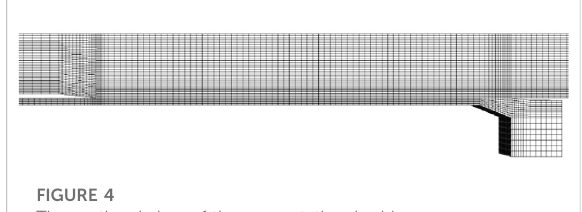
FIGURE 4 The sectional view of the computational